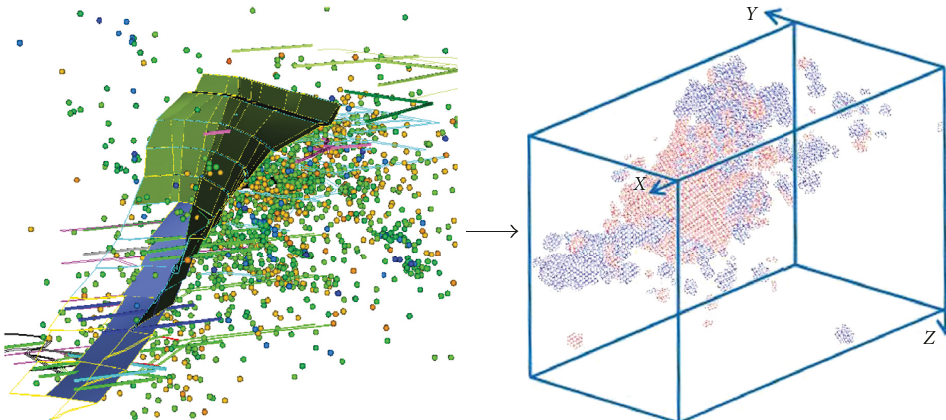
Figure 14: Computational domain of the back analysis of the right bank